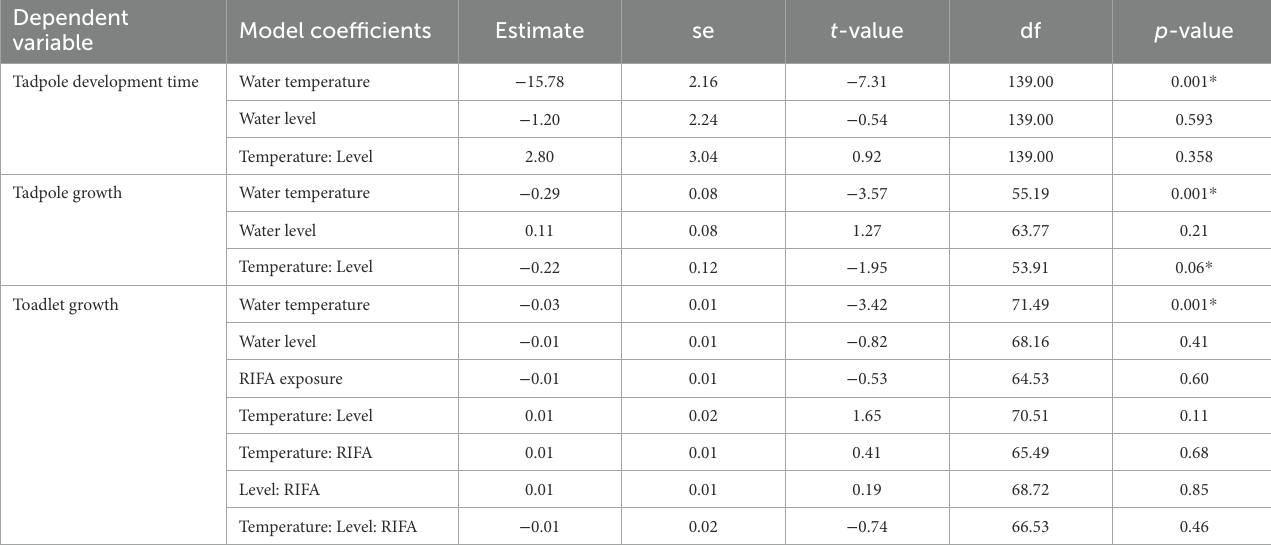
TABLE 6 Results of mixed-effects models for tadpole development time, tadpole growth, and toadlet growth analyzes for I. nebulifer . Dependent variable